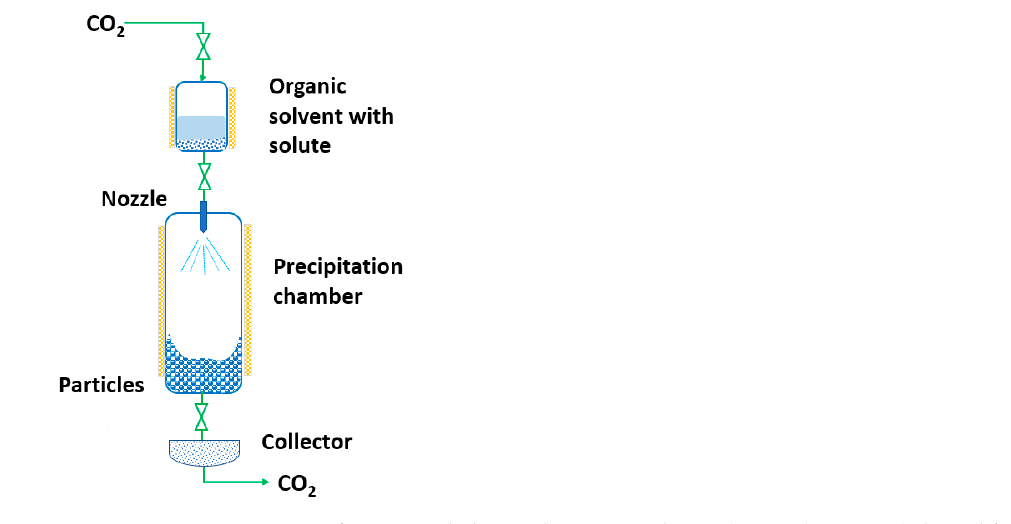
Figure 7. Depressurization of an Expanded Liquid Organic Solution (DELOS) process (adapted from Costa et al. [137]).